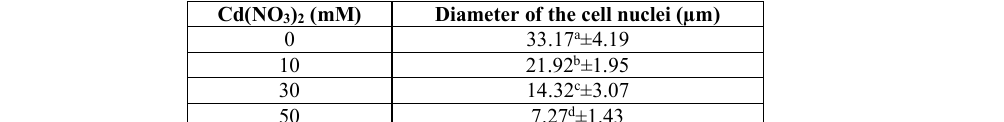
Table 2. Nuclei diameter of C. roseus callus cells after 3 days of treatment with different concentrations of Cd(NO 3 ) 2 .